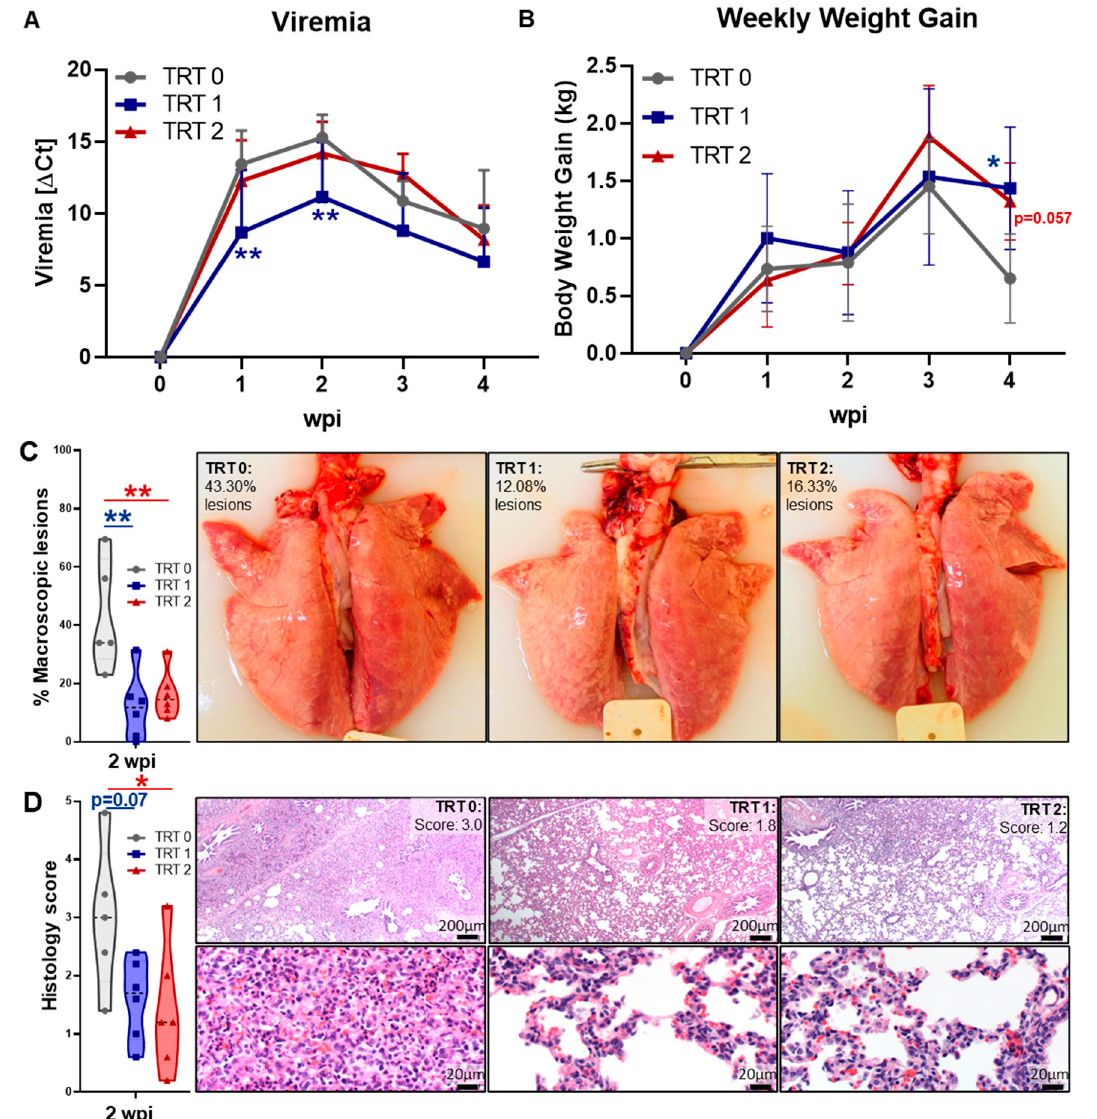
Figure 2. Maternal AIV vaccination boosts immunity to PRRSV-2 in 2-week old piglets: Viremia ( A ) and weekly body weight gains ( B ) were analyzed at different weeks post inoculation (wpi). For both, data were analyzed by mixed-effects model (REML) with Dunnett’s multiple comparisons test. ( C ) Percentage of macroscopic lung lesions, and ( D ) lung interstitial pneumonia histology scores at 2 weeks post inoculation. Data in ( C ) and ( D ) were analyzed by one-way ANOVA with Dunnett’s multiple comparison. All differences are shown within time point and compared to the TRT 0 control group – ** p < 0.01 and * p < 0.05.